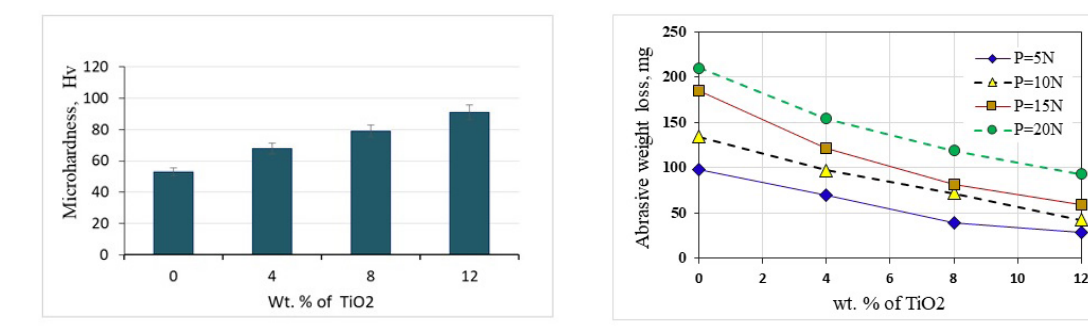
Nano composites Figure 8. The measured microhardness of Cu-TiO Figure 9. Correlation between abrasive weight loss (mg) and nano- 2 with different wt. % of TiO nanoparticles. TiO2 content at sliding distance of 200m and different applied loads. 2